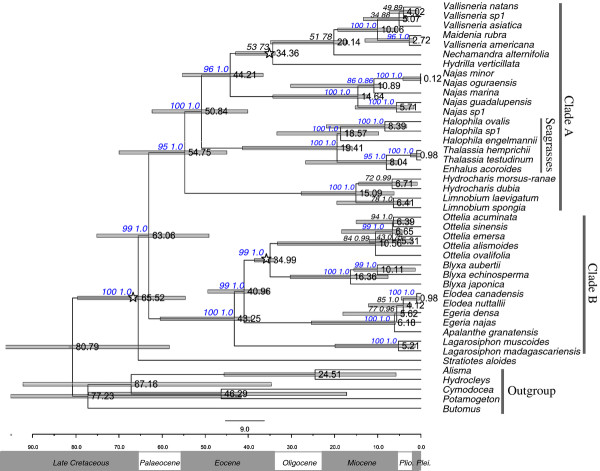
Phylogeny and divergence time estimates of Hydrocharitaceae based on combined 18S + rbcL+ matK+ trnK 5' intron + rpoB+ rpoC1 + cob + atp1 data set. Numbers above branches refer to the maximum likelihood bootstrap values (BS, left) and the posterior probabilities (PP, right). Numbers in blue refer to the branches with BS> 95 and PP = 1.0. Gray bars indicate 95% highest posterior distributions, and nodes labelled with stars refer to the positions of fossil calibration points.